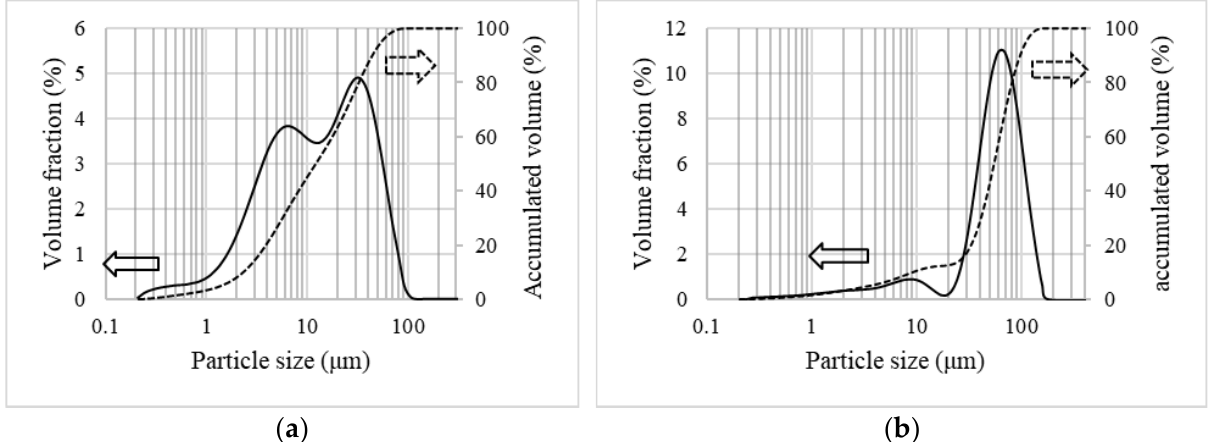
Figure 1. Particle size distribution for the EAFD powders: ( a ) G1 [15] and ( b ) G2. The solid lines represent the particle size distribution, and the dashed lines indicate the accumulated volume. Analysis of the XRD patterns (Figure 2) reveals the presence of ZnO and Fe 3 O 4 and/or ZnFe 2 O 4 as major compounds for both G1 and G2. Fe 3 O 4 and ZnFe 2 O 4 share the spinel structure with close cell parameters, and it cannot be concluded here if it is one or the other compound. Using Mössbauer spectroscopy, Machado and collaborators [39] were able to verify the presence of these two phases in an EAFD sample with a finer particle size (average diameter 1.88 µ m), the Fe 3 O 4 and ZnFe 2 O 4 representing 14% and 29% of the EAFD, respectively. There is also more free SiO 2 in G2 than in G1, which is in agreement with the silicon content found by XRF (Table 1).